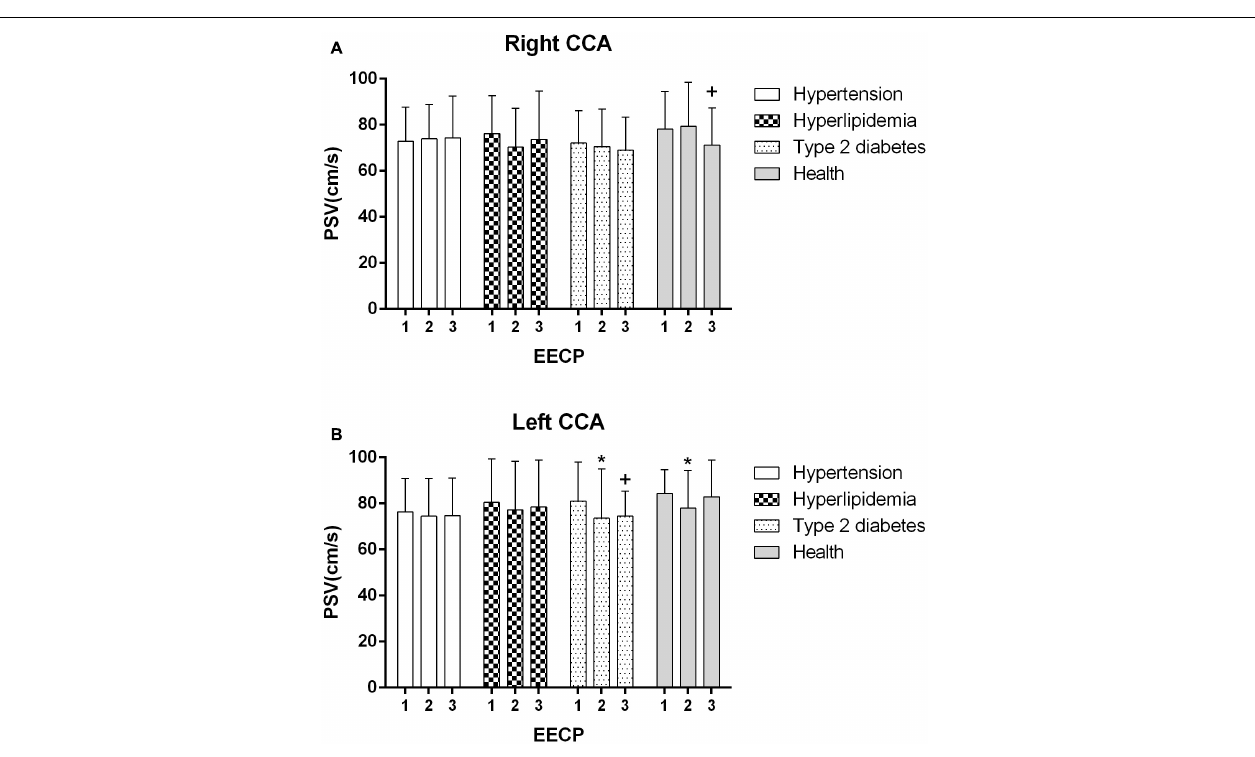
Frontiers in Physiology |